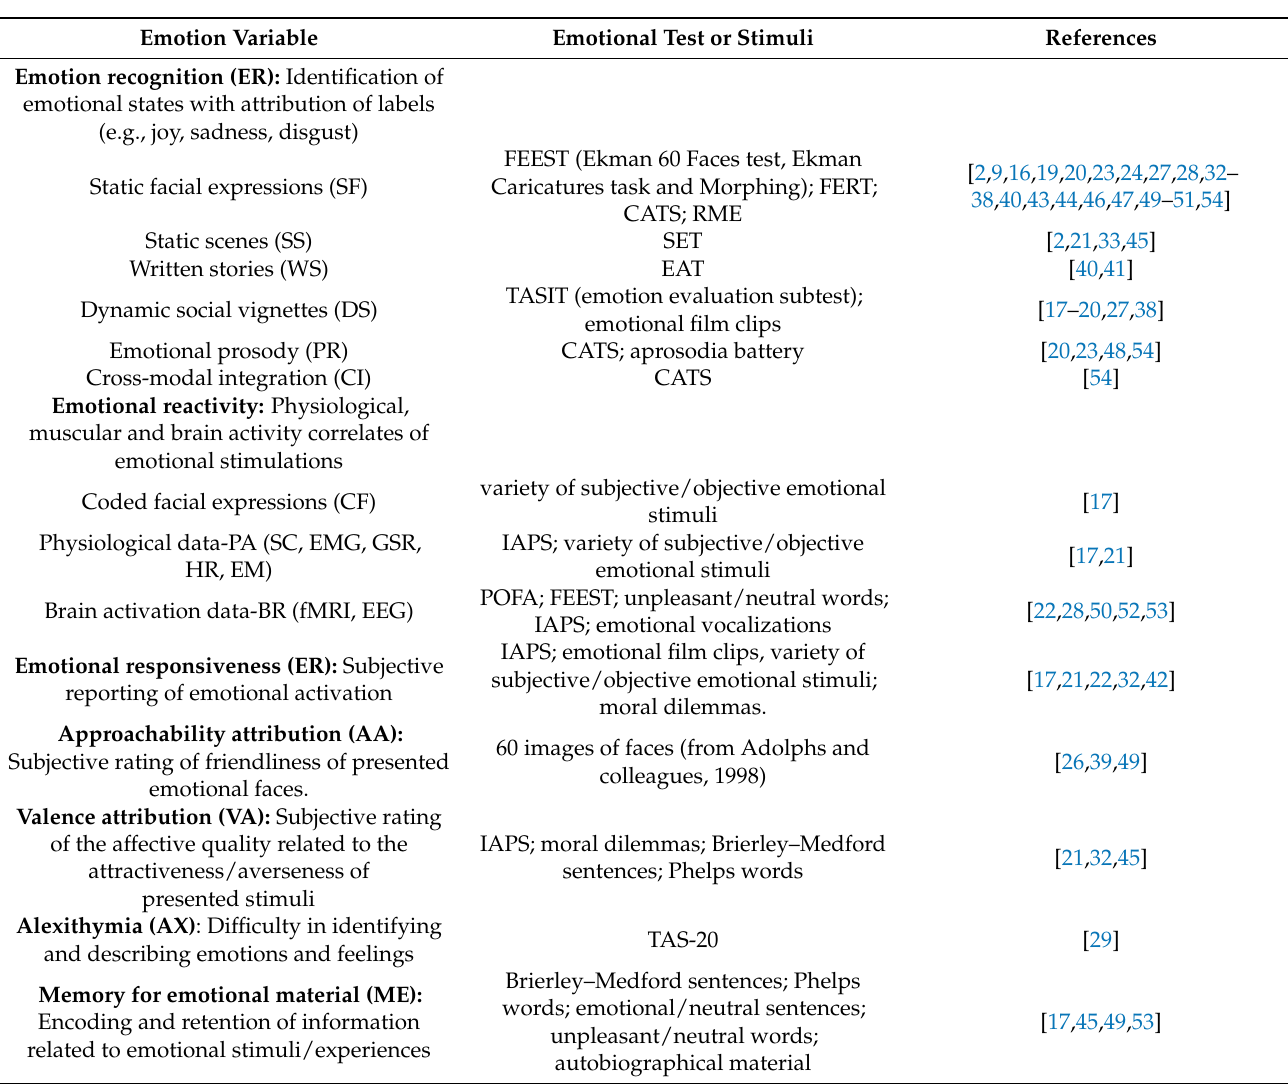
Table 1. Description of emotional variables, tests and